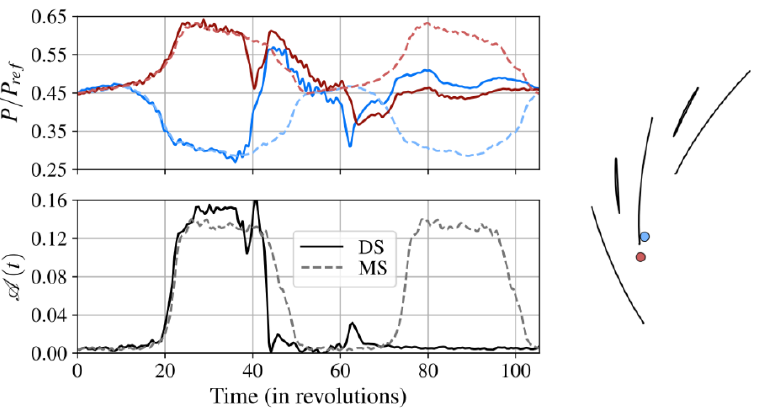
Figure 13. Comparison of the evolution of the unsteady alternate rate during a deep surge (DS) and a phase averaged mild surge period (MS) .